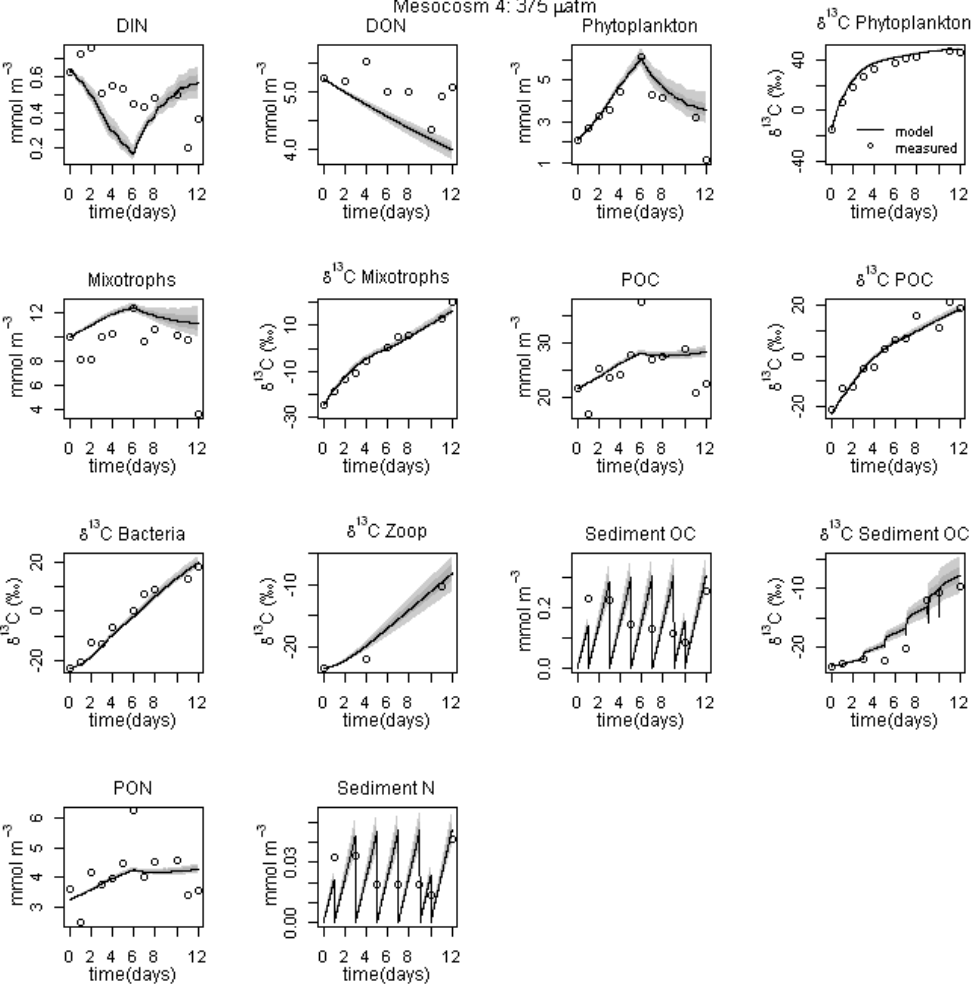
Fig. 5. MCMC plots showing the best fits of model output (solid line) with uncertainty (grey envelopes) fitted to the data (points) for one mesocosm (M4, 375µatm). Fits of the other mesocosms are presented in the supplementary